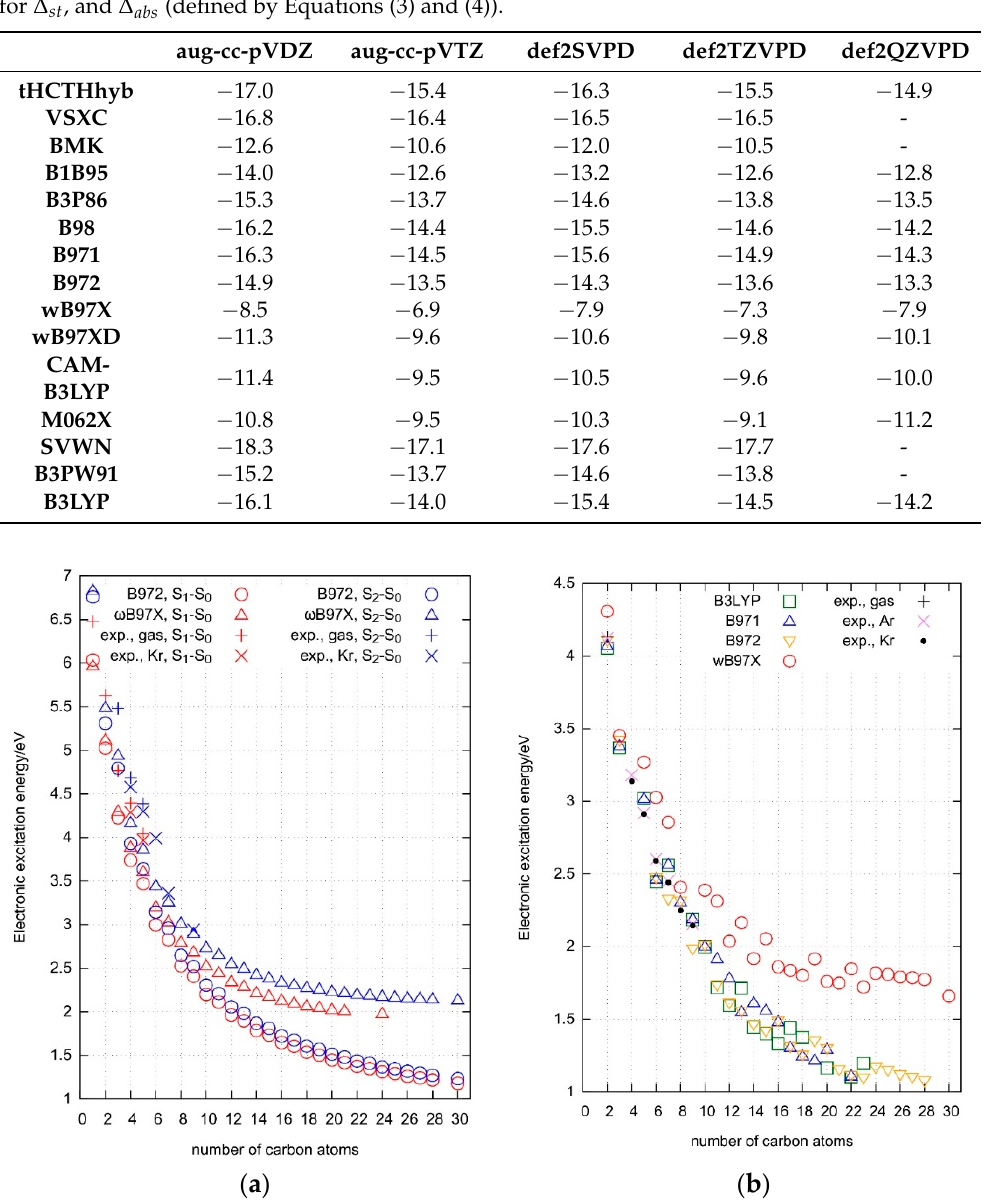
Figure 2. Vibrationless (0-0) excitation energy values plotted against the number of carbon atoms; ( a ) S 1 -S 0 and S 2 -S 0 ; ( b ) T 1 -S 0 . All calculations performed with the aug-cc-pVTZ basis set; results